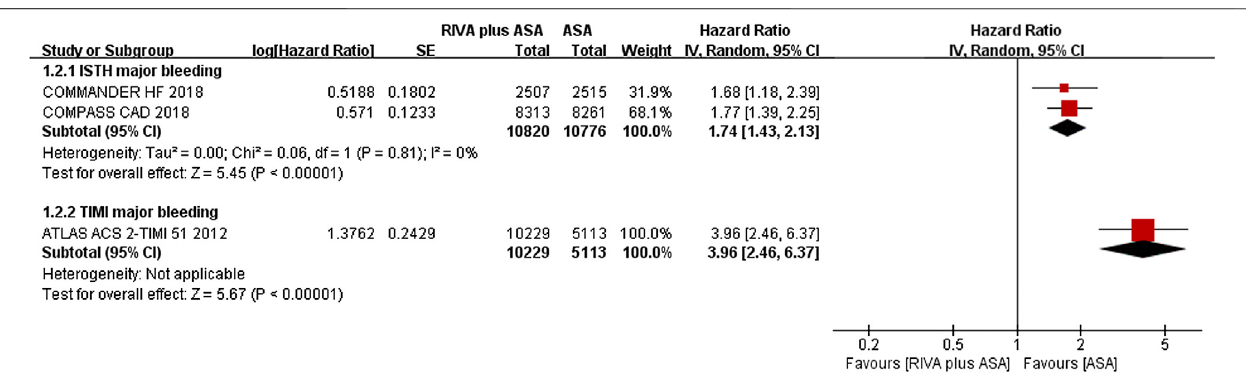
FIGURE3| Forest plot ofthe riskofmajor bleeding incoronary artery disease patients treatedwithrivaroxabanplus aspirin and aspirin. ISTH, International Society on Thrombosis and Haemostasis; TIMI, Thrombolysis in Myocardial Infarction; RIVA, rivaroxaban; ASA, aspirin; IV, inverse variance; COMPASS CAD, coronary artery disease in the Cardiovascular Outcomes for People Using Anticoagulation Strategies trial; COMMANDER HF, A Study to Assess the Effectiveness and Safety of Rivaroxaban in Reducing the Risk of Death, MyocardialInfarction, or Stroke in Participants with Heart Failure and Coronary Artery Disease Following an Episode of DecompensatedHeartFailure;ATLASACS2-TIMI51,Anti-XaTherapytoLowerCardiovascularEventsinAdditiontoStandardTherapyinSubjectswithAcuteCoronary Syndrome-Thrombolysis in Myocardial Infarction 5.